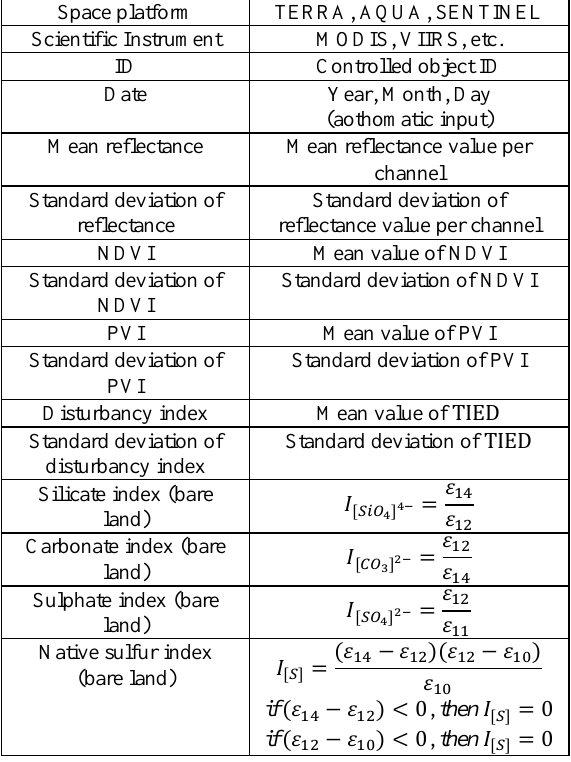
Table 2. Attributes of control products for space monitoring of the TWDS impact on surrounding vegetation The generated series of observations can be marked by the user for high-quality and incorrect observations with subsequent export in tabular format (xls). The series of data can by studied with analytic module providing automatic charting, which provides the opportunity to analyse the seasonal, annual and long-term dynamics of changes in objects (see Figure 6).